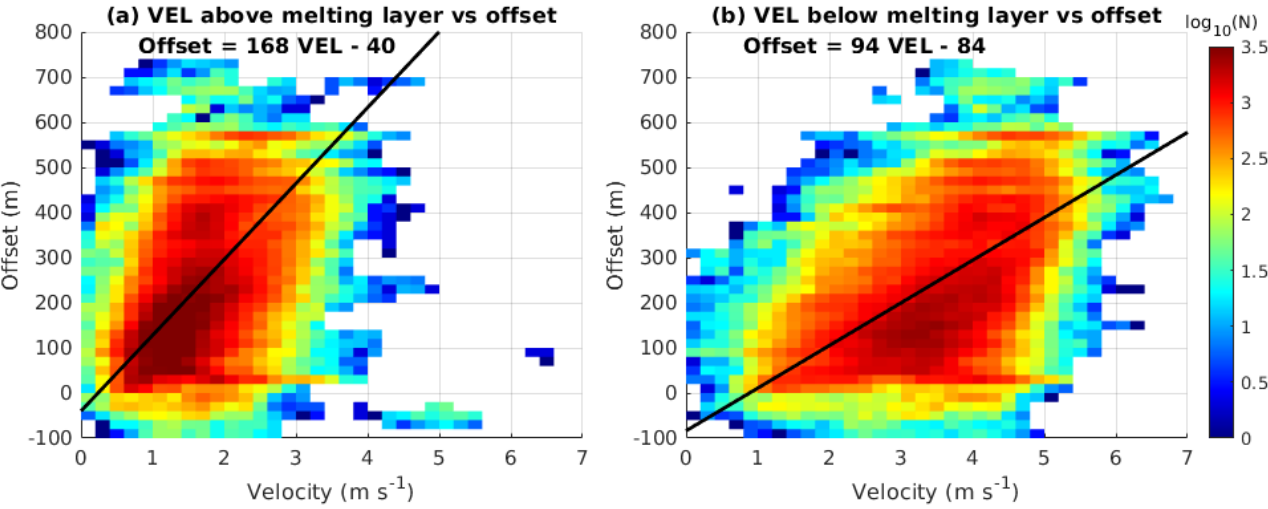
Figure 8. Scatter plot of 10 gate mean radial velocity above ( a ) and below ( b ) the melting layer vs. offset between the 0 °C isotherm and the melting layer with geometric regression line (black). Color shading shows the number of data points in logarithmic units.